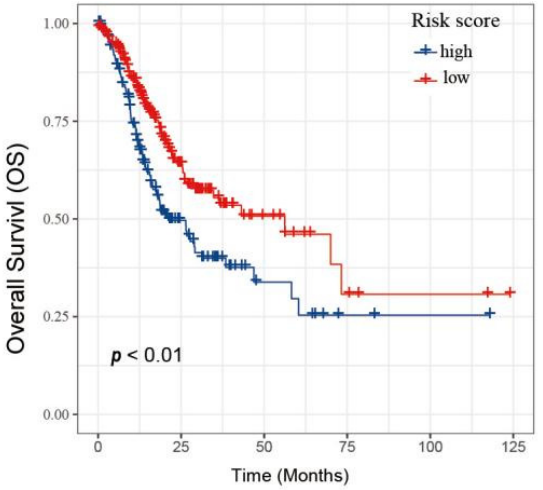
Figure 9. Validation of the risk score model based on TCGA database.